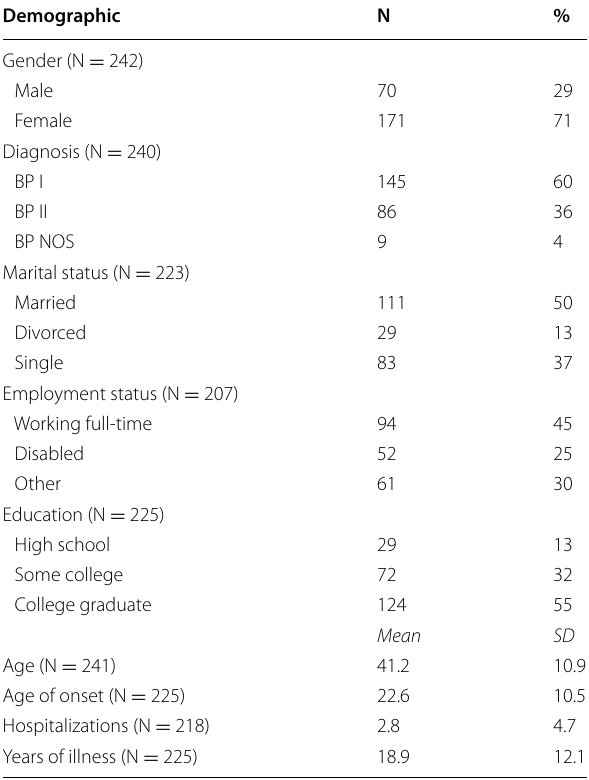
Table 2 Psychotropic medications taken during the 100-day analyses periods (N